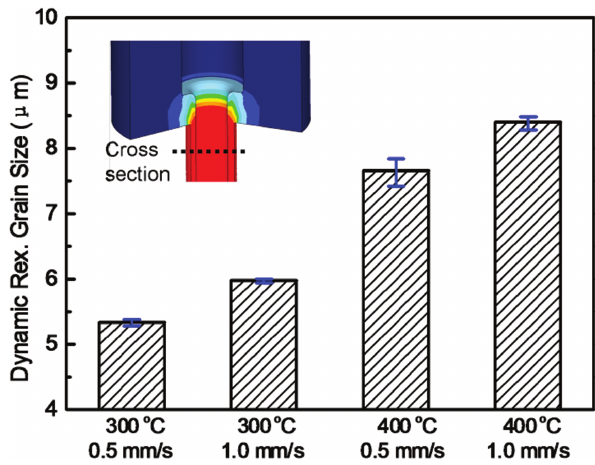
Figure 11: Dynamic recrystallization grain size on the cross-section, under different extrusion conditions: (a) 300 ℃ , 0.5mm/s; (b) 300 ℃ , 1mm/s; (c) 400 ℃ , 0.5mm/s; and (d) 400 ℃ ,